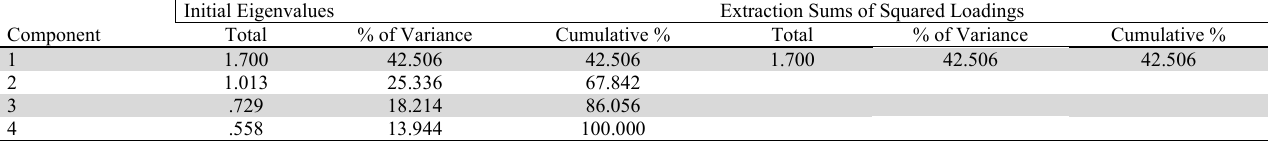
Testing the variance extracted of factors